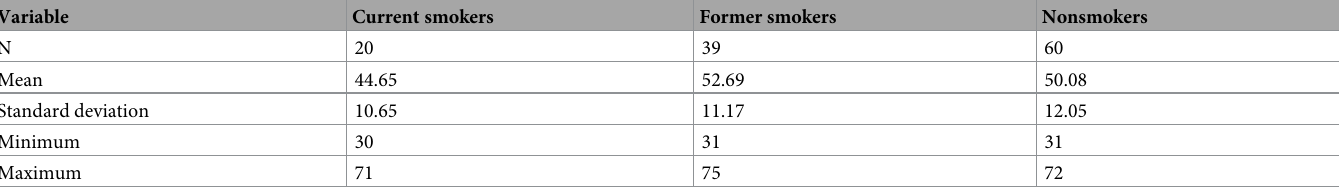
Table 1. Age of participants